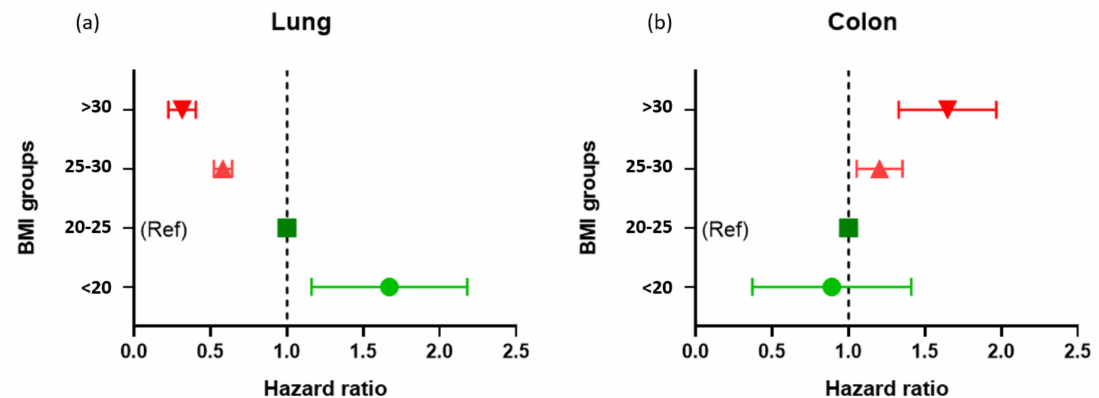
Figure 2. ( a ). Risk for lung cancer across groups of body mass index over 43 years of follow-up. Cox proportional hazards analysis with 95% confidence intervals for lung cancer incidence over time across BMI categories. The multivariate model was adjusted for age (five-year increments), height (cm), and cigarette smoking at any time up to and including 1963. ( b ). Risk for colon cancer across groups of body mass index over 43 years of follow-up. Cox proportional hazards analysis with 95% confidence intervals for colon cancer incidence over time across BMI categories. The multivariate model was adjusted for age (five-year increments), height (cm), and cigarette smoking at any time up to and including